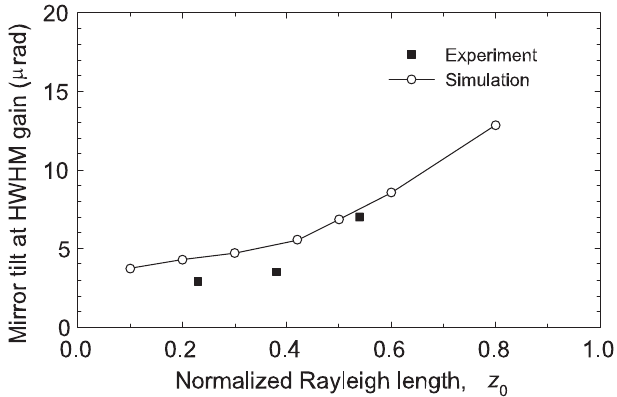
FIG. 6. Mirror tilt at HWHM gain versus z 0 .